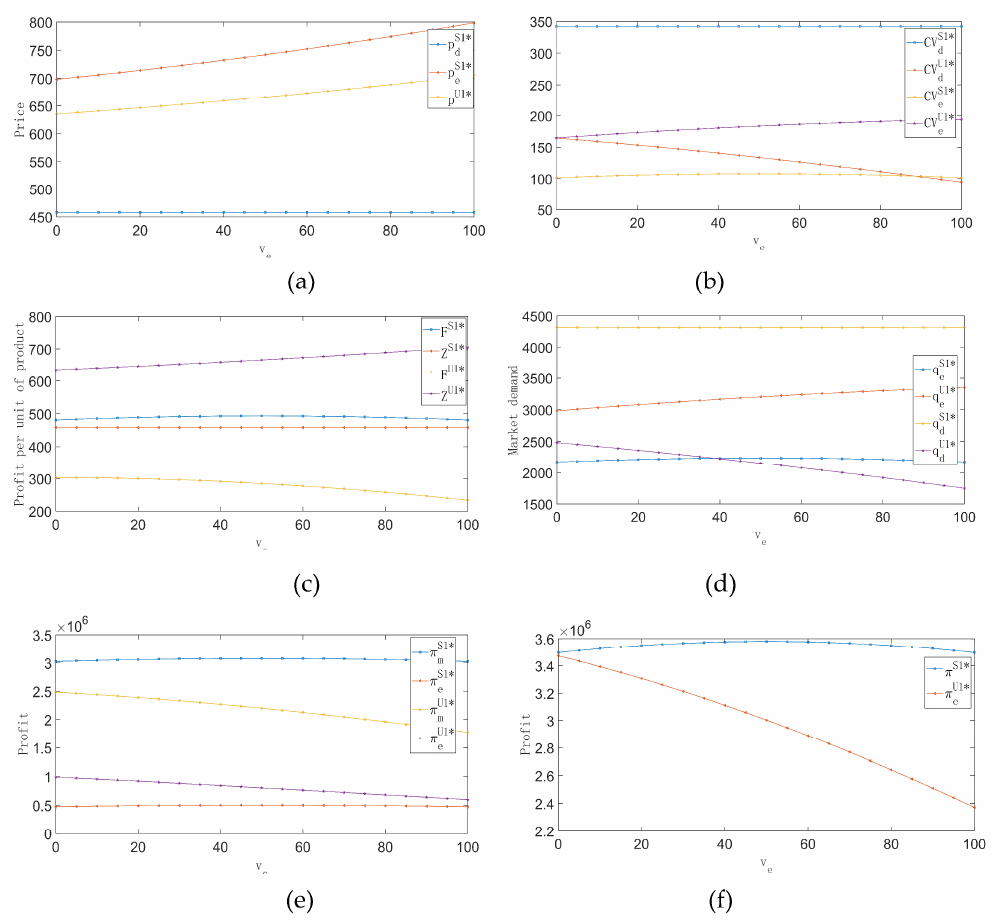
Figure 2. The impact of value-added services value v e on equilibrium results under decentralized decision-making. ( a ) The impact of v e on sales price. ( b ) The impact of v e on customer value. ( c ) The impact of v e on unit product profit. ( d ) The impact of v e on market demand. ( e ) The impact of v e on profits of two parties. ( f ) The impact of v e on total profit of supply chain.